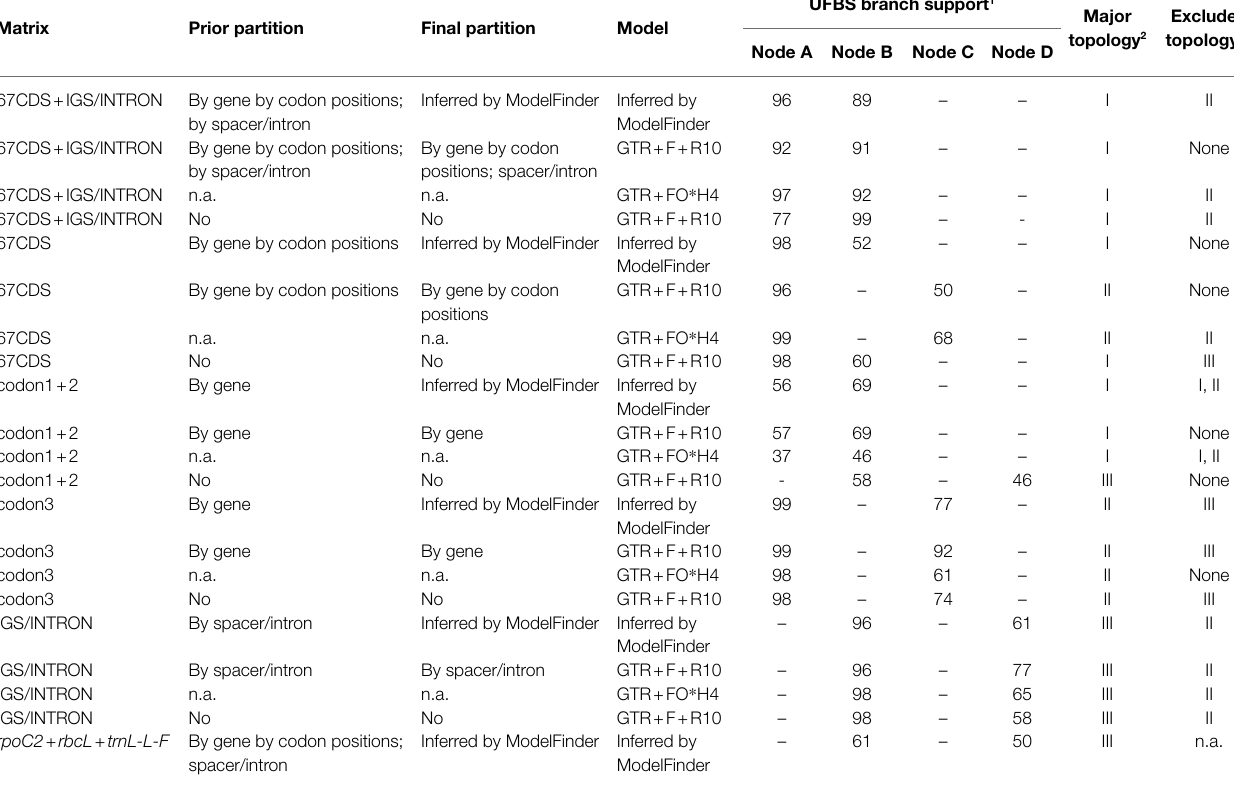
1 Showing only values from the major topology. 2 The topologies in Figure 2 . 3 The significantly (p < 0.05) excluded topology inferred by one of these methods: bp-RELL, p-KH, p-SH, p-WKH, p-WSH, c-ELW, and p-AU, detailed in “Topology Tests” of Minh et al.